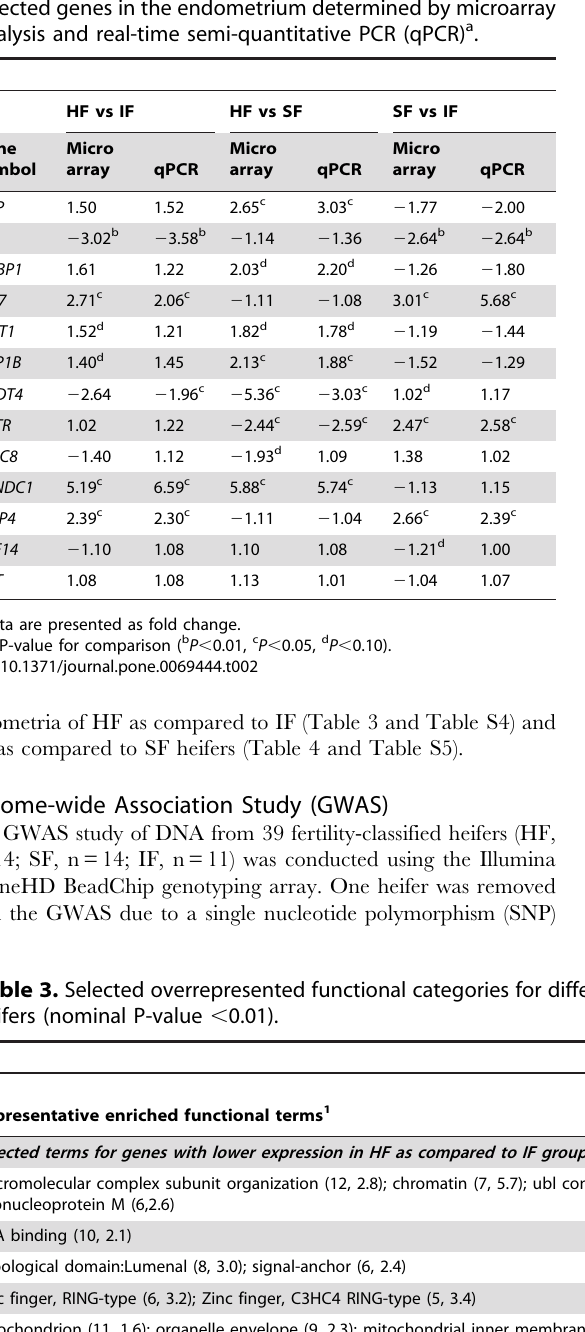
Table 2. Comparison of endometrial mRNA levels for selected genes in the endometrium determined by microarray analysis and real-time semi-quantitative PCR (qPCR) a .